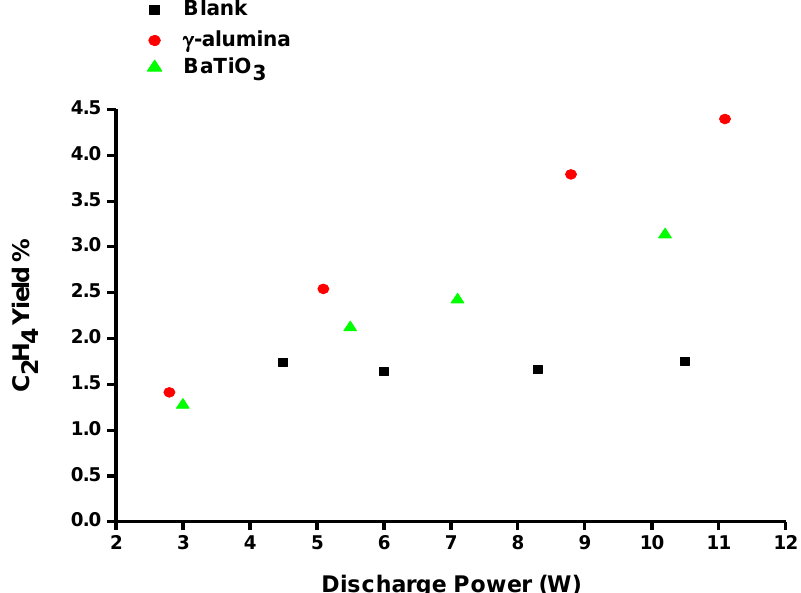
Figure 14. Yield of C 2 H 4 as a function of discharge power for the reactor packed with BaTiO 3 and γ -alumina and the blank reactor.